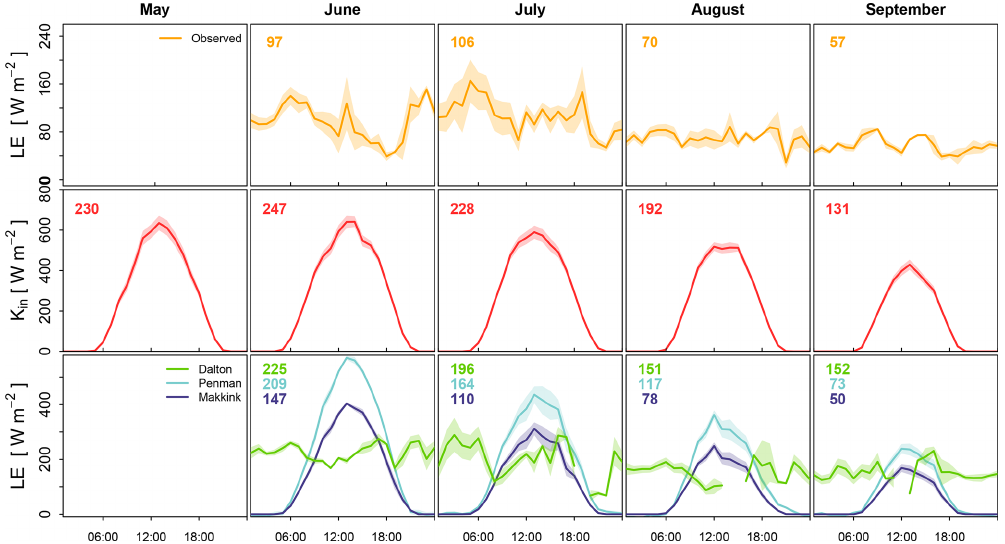
Figure C1. An illustration of the decoupling at Trintelhaven in 2019 between the monthly average diurnal cycles of observed latent heat flux (top panels) and global radiation (middle panels), with the latter forming the basis of the frequently used evaporation models of Penman (1948) and Makkink (1957). These models are shown together with the model of Dalton (1802) in the bottom panels. Note that some variables included in the evaporation models are measured at heights above the 2m that is prescribed (see Eqs. 6–12). Additionally, all three models are generally used on a daily basis, but they are presented here to show the underlying daily cycle. The shaded area represents the uncertainty, which is defined as the standard deviation divided by the square root of the number of observations. Average daily means of the respective variables are indicated by the number in the top left of each panel and display the average course over the summer